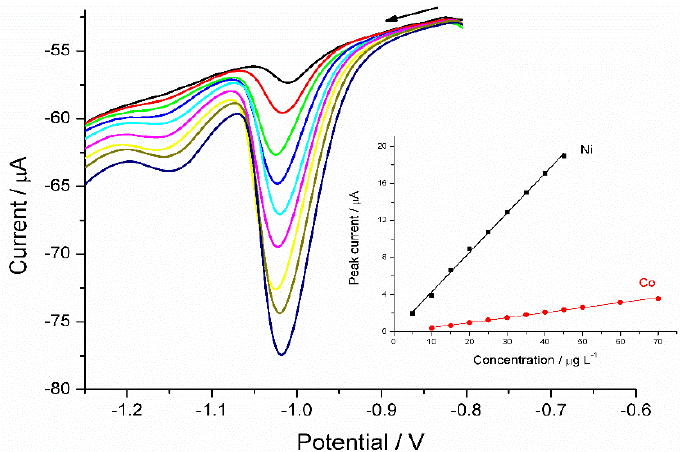
Figure 5. AdCSVs at Bi-PPCE for increasing concentration of Ni(II) and Co(II) in 0.1 M ammonia buffer solution (pH = 9.0), 10 mg∙L −1 Bi(III), 1 × 10 −5 mol∙L −1 DMG